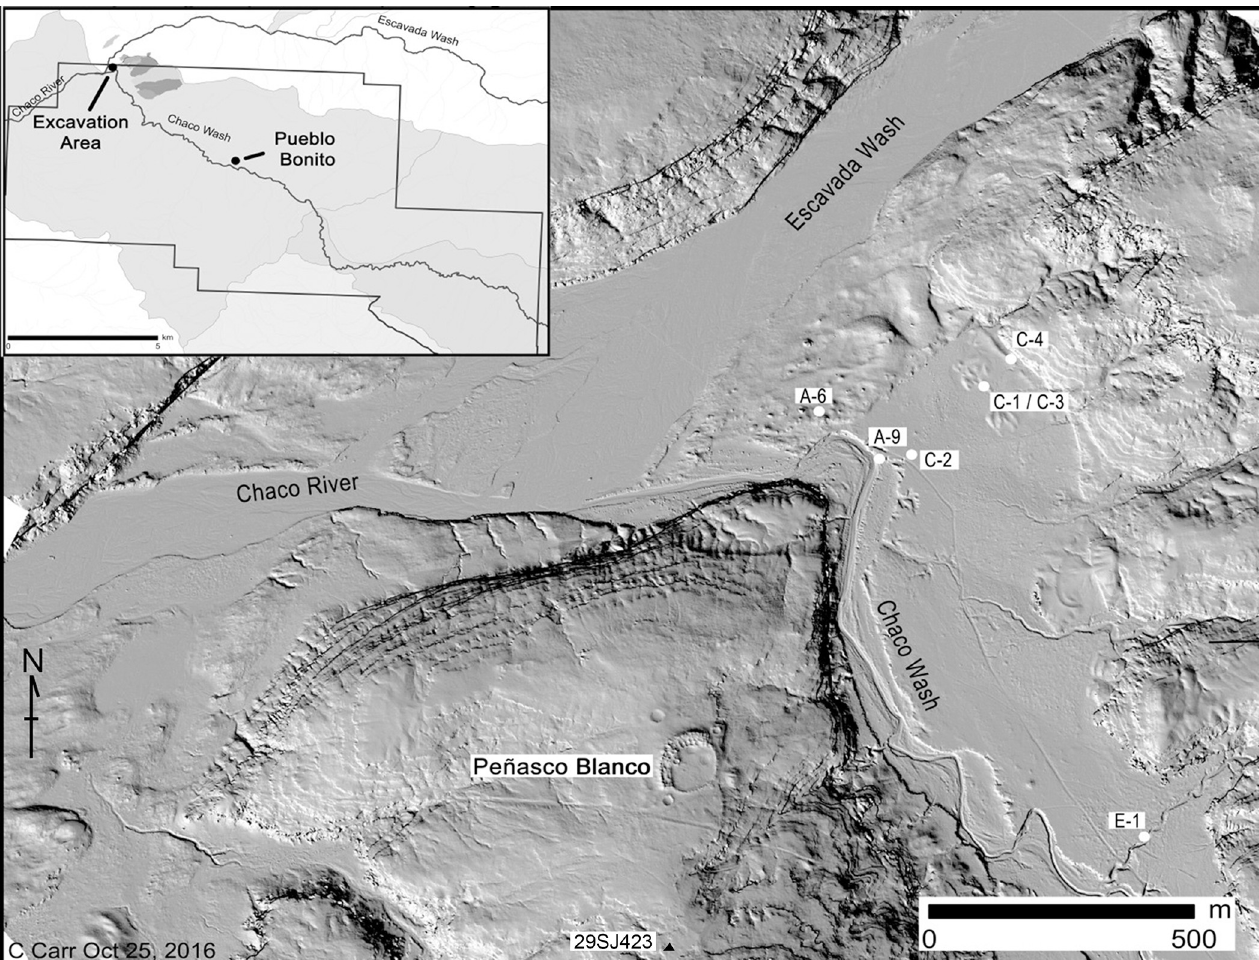
Fig 2. Hillshade view of the confluence of Chaco Wash and Escavada Wash. Map reveals the locations of excavation units discussed in the text (Image created by Christopher Carr and David Lentz. Base map [18]. Reprinted from [19] under a CC BY license, with permission from Vernon L. Scarborough, original copyright